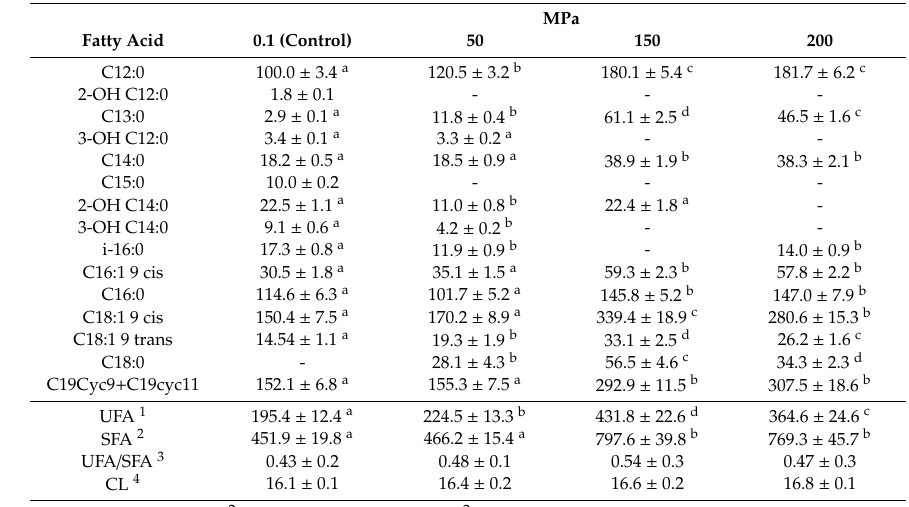
Table 3. Membrane FA composition of Lb. paracasei A13 in relation to the HPH treatments applied. Values are expressed as ppm ± SD. In the same line relative to each fatty acid, means ± SD followed by di ff erent superscript letters (a, b, c or d) are significantly di ff erent p < 0.05. Missing values (-) were under the detection limit.